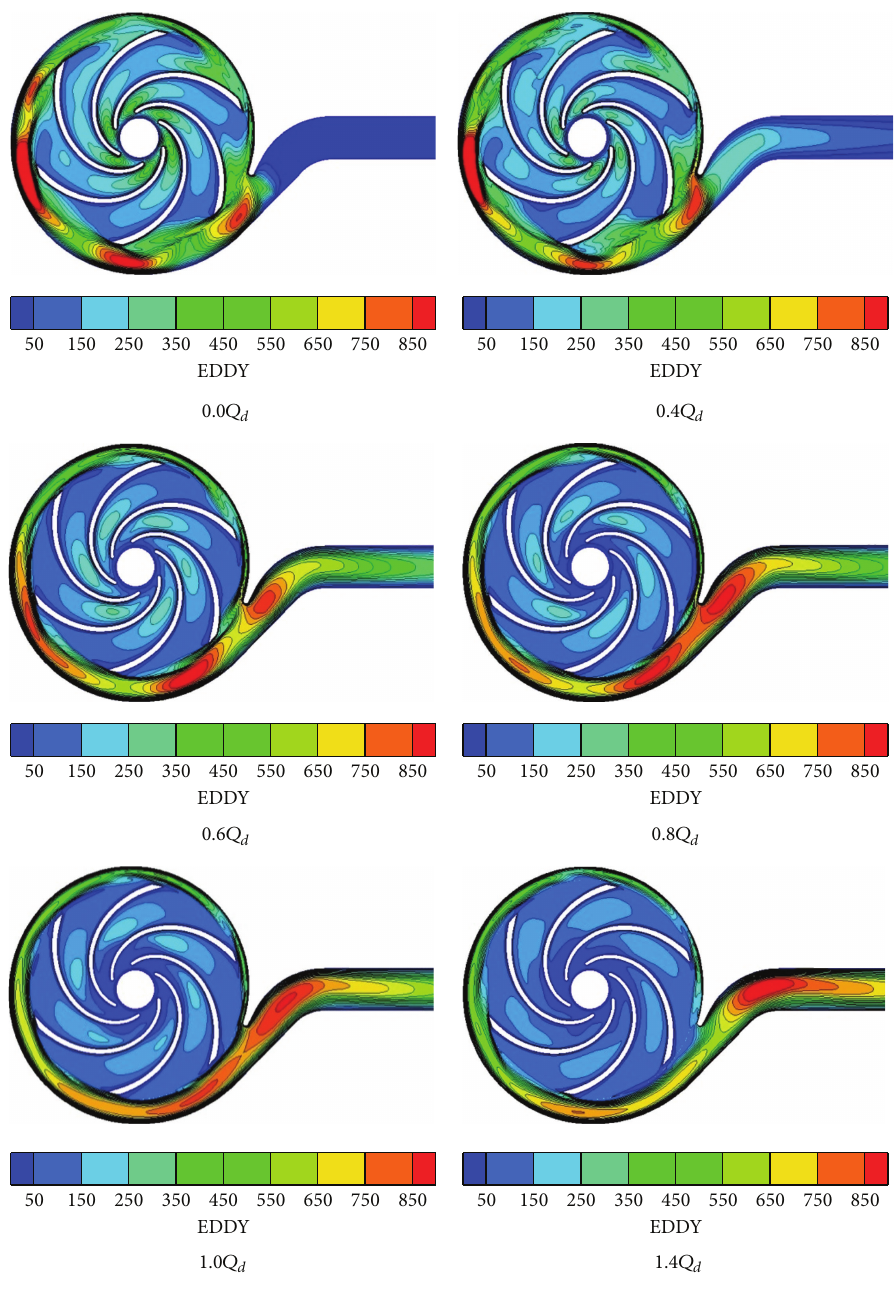
Figure 11: Contour of eddy viscosity ratio at different flow